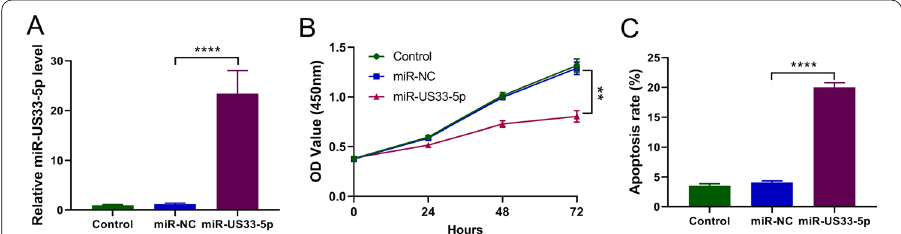
Fig. 2 HCMV-miR-US33-5p inhibits HA-VSMC proliferation and promotes their apoptosis. HA-VSMCs were transfected with HCMV-miR-US33-5p. A qRT-PCR analysis of HCMV-miR-US33-5p expression level. B CCK-8 assay indicated that HCMV-miR-US33-5p significantly inhibited cell proliferation starting from 24 h after transfection. C Flow cytometry analysis indicated that HCMV-miR-US33-5p significantly increased HA-VSMC apoptosis. * P < 0.05, ** P < 0.01, *** P < 0.001 ( n 3, ANOVA =